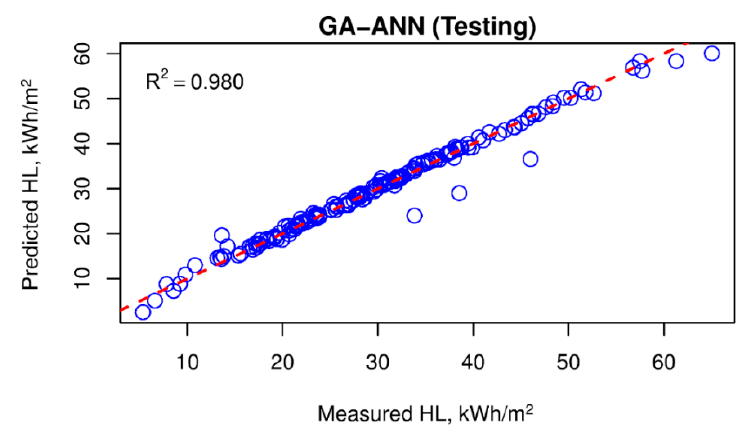
Figure 9. HL predictions on the testing dataset of the GA-ANN model.